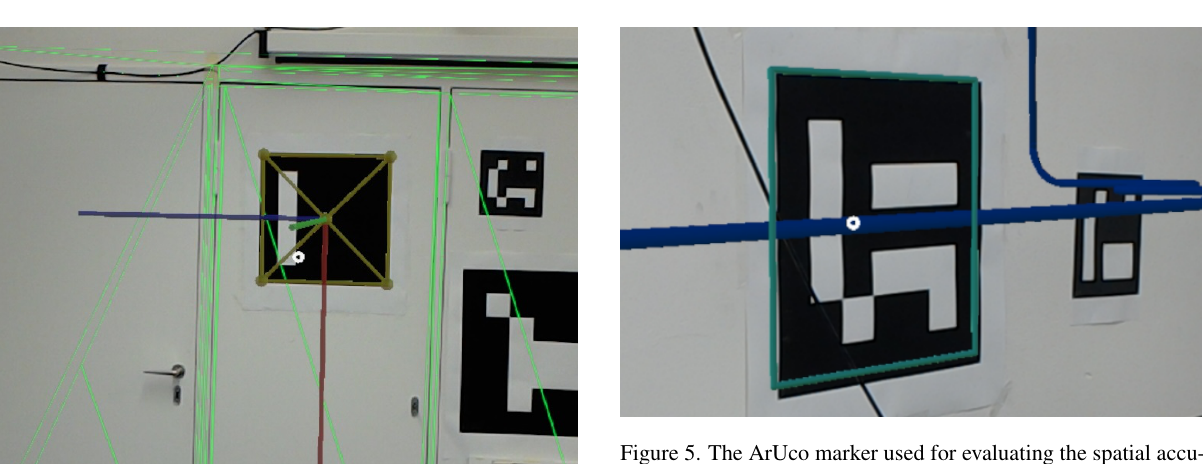
Figure 5. The ArUco marker used for evaluating the spatial accu- racy of its overlay with the room model (blue